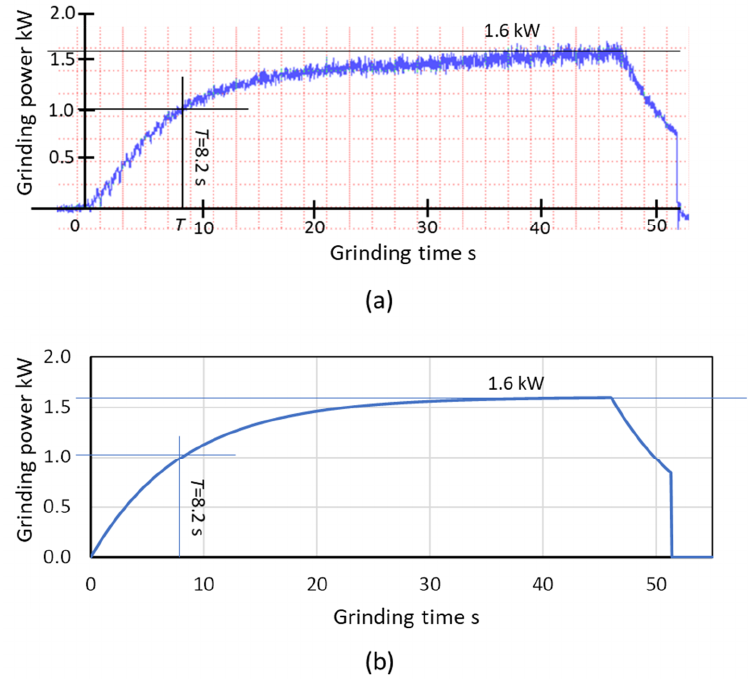
Figure 20. Test results and simulation for infeed cylindrical grinding. ( a ) Power of infeed cylindrical grinding (Experimental); ( b ) Simulation of infeed cylindrical grinding (Theoretical).